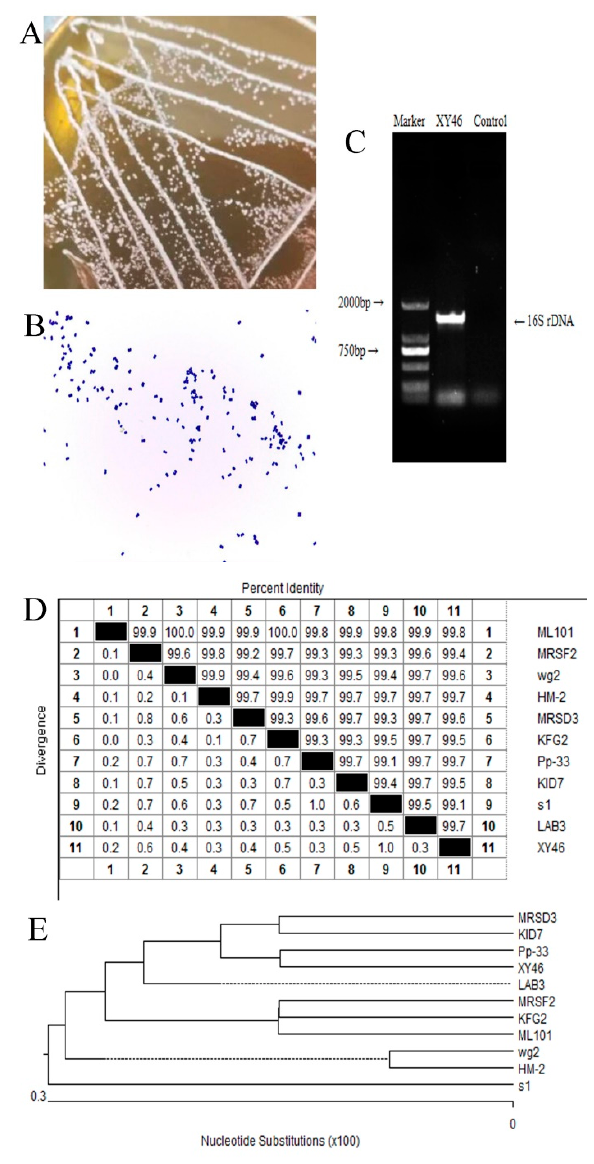
Figure A1. Colony morphology and Gram staining results for the xy46 strain grown on an MRS culture plate, showing: ( A ) the xy46 strain inoculated on an MRS agar plate and anaerobically cultured for 24 h at 37 °C, ( B ) a single colony used for Gram staining, ( C ) electrophoresis results for the 16S rDNA PCR products of xy46, ( D ) 16S rDNA sequence homology analysis of xy46, and ( E ) the phylogenetic tree obtained by comparing the 16S rDNA sequences from the xy46 with the GenBank database.